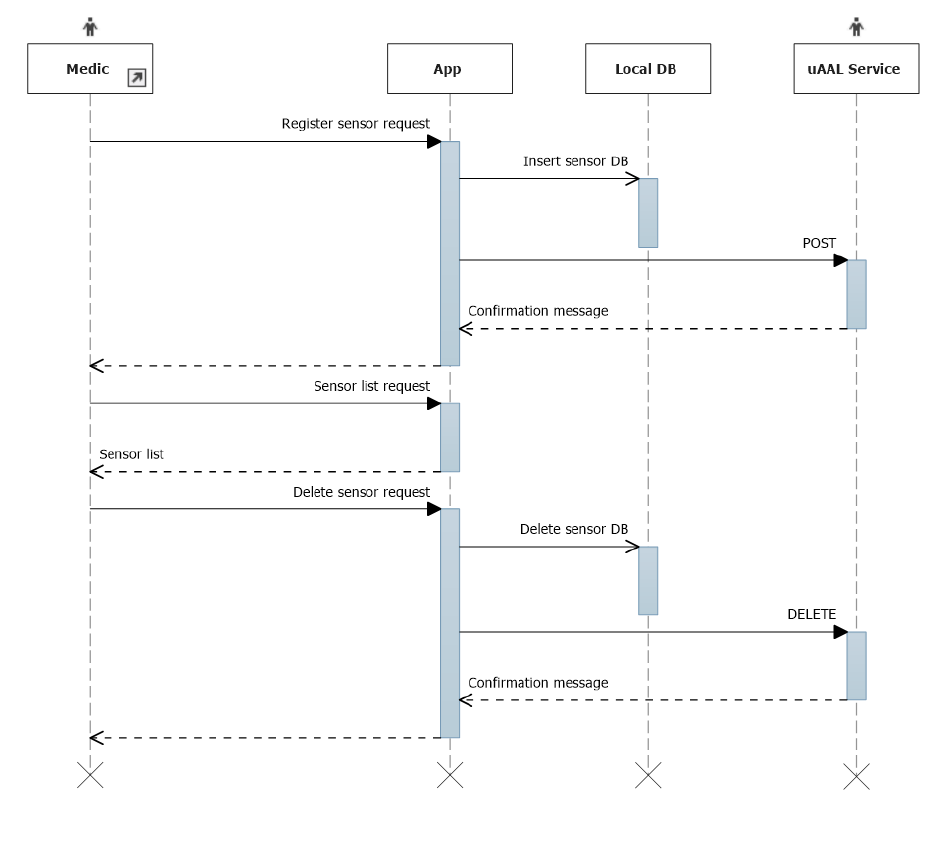
Figure A2. Sequence diagram of the sensor-management